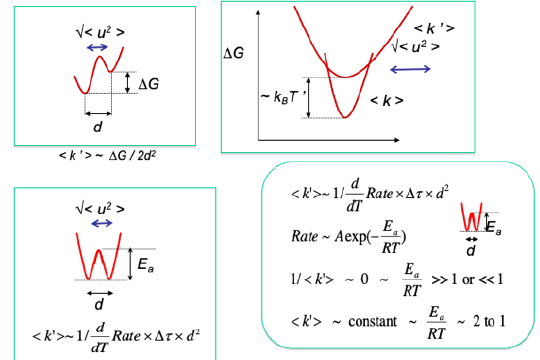
Fig. 3. The two-well model (top left) is from [12], the top right one is from [17]. The model on the bottom, in which two wells of the same free energy are separated by an activation energy barrier, would be appropriate, for example, to methyl group